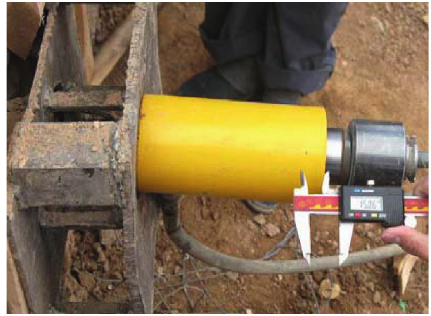
Figure 3: Loading steel bar installation.